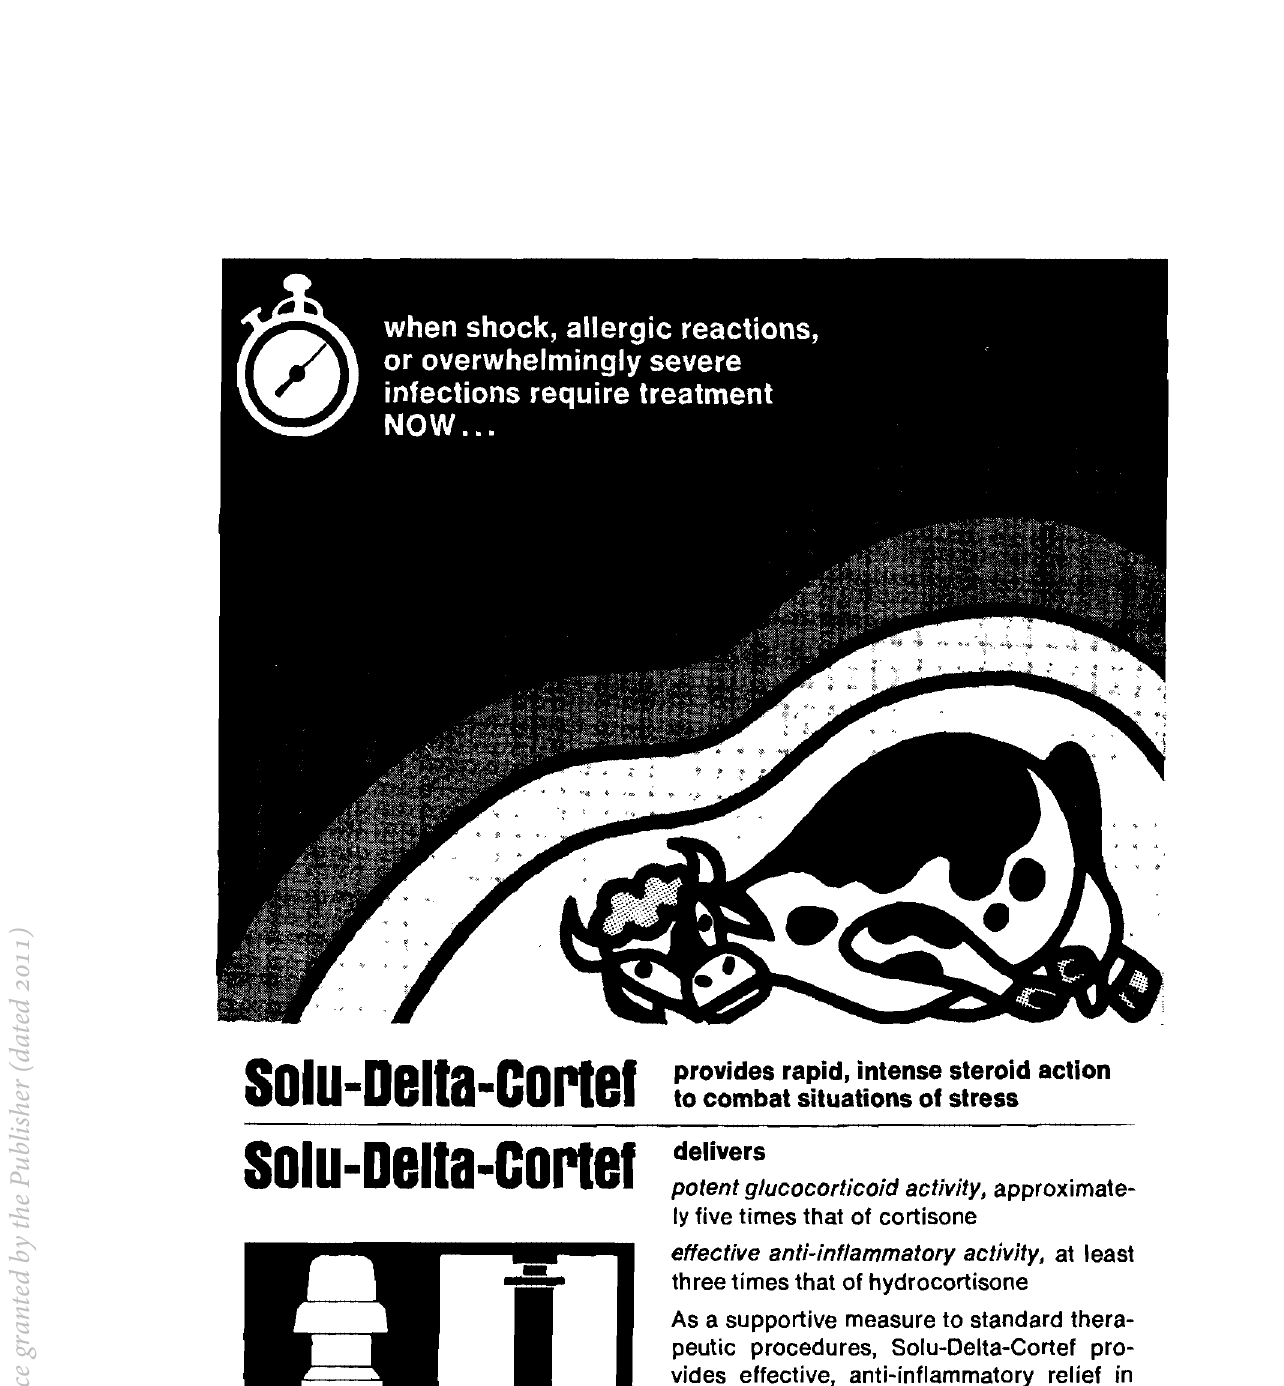
vides effective, anti-inflammatory relief in large and small